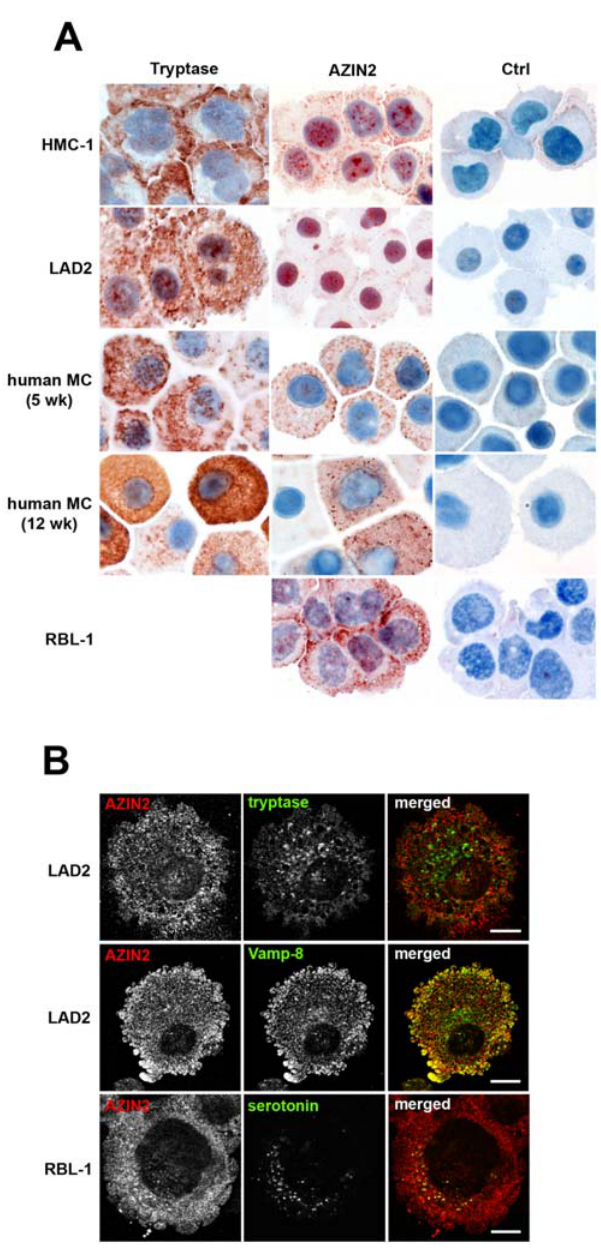
Figure 3. Granular expression of AZIN2 in MC lines and primary human MCs. (A) The MCs were immunostained with either anti-tryptase, AZIN2 antiserum 3 (HMC-1, LAD2, and RBL-1), antiserum 2 (primary human MCs) or the corresponding rabbit preimmune sera (Ctrl). Note the high variation of AZIN2 expression between individual human MCs cultured for 12 weeks. Original magnification for all panels 6 1000. (B) Confocal laser scanning microscopy for AZIN2 with MC granule markers tryptase and Vamp-8 in LAD2 cells, and serotonin in RBL-1 cells. Double-immunofluorescence staining was performed using rabbit antiserum 2 together with monoclonal antibody to tryptase, mouse anti-Vamp-8 or monoclonal antibody to serotonin, followed by Alexa Fluor-555 conjugated donkey anti-rabbit and Alexa Fluor-488 conjugated donkey anti-mouse IgGs. The right panel represents merged images; yellow indicates the co-localization. Bars represent 10 m m.